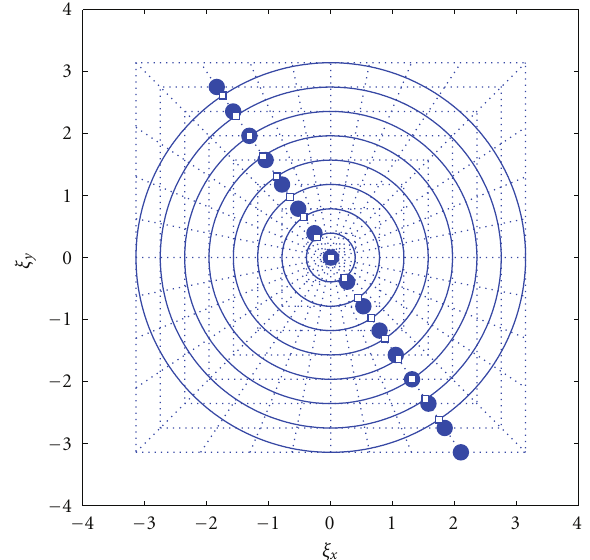
Figure 4: Circle the squares interpolation stage. Circles denote the known pseudo-Polar grid points while the squares are the destina- tion equiangular spaced rays. (This figure first appeared in [33]). The new points are located along the same line and are equispaced with a di ff erent spacing (see Figure 4). The final grid is shown in Figure 5.